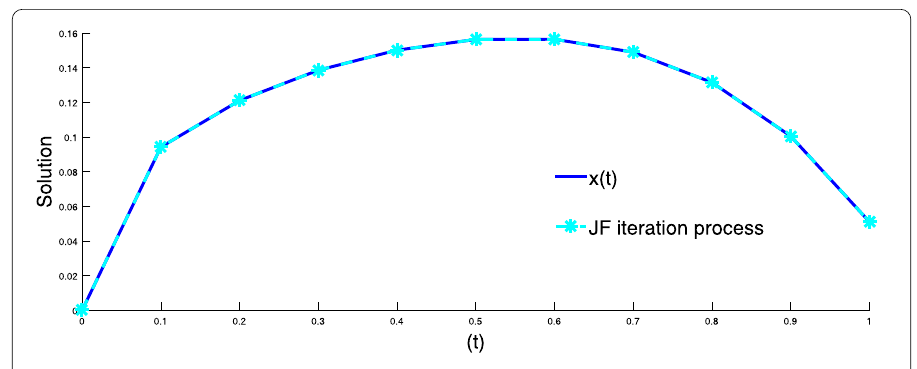
Figure 4 Graphical representation of exact solution and approximated solution of problem (6.3) by using the JF iteration process at k = 11